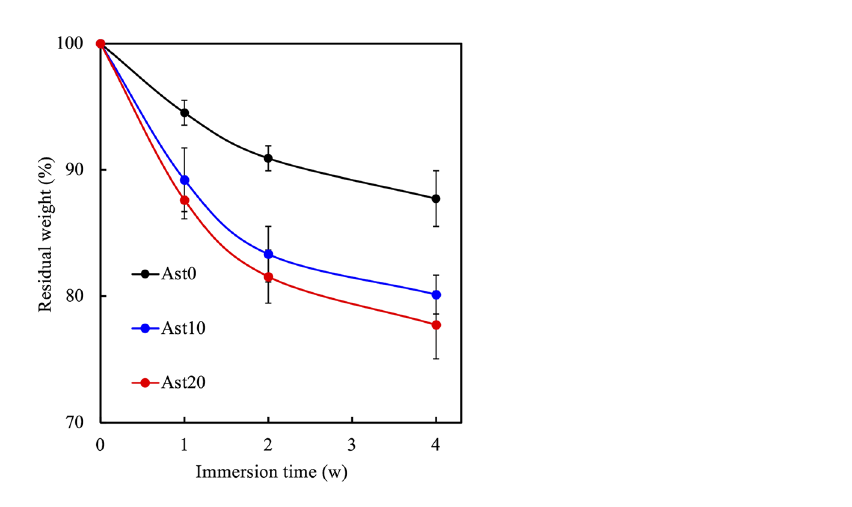
Figure 4. The weight loss of 3D-printed Ast-containing PU nerve conduits after immersion in simulated body fluid (SBF).